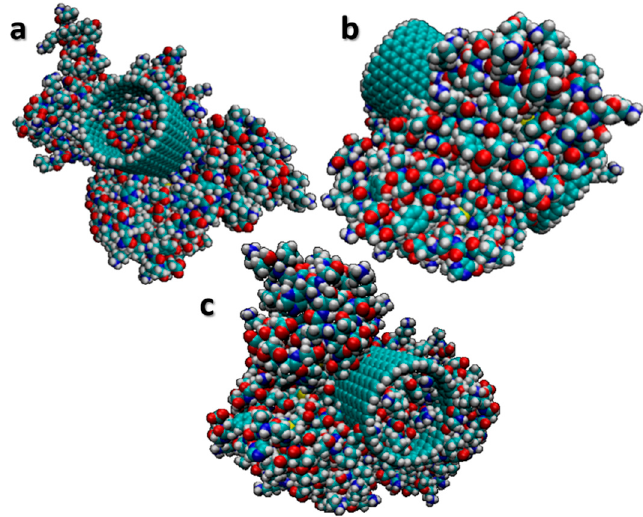
Figure 4. Single-wall carbon nanotube (SWCNT) conjugated with sodium alginate (ALG), chitosan (CHI), folic acid, and doxorubicin hydrochloride. ( a – c ) The structure in various orientations.